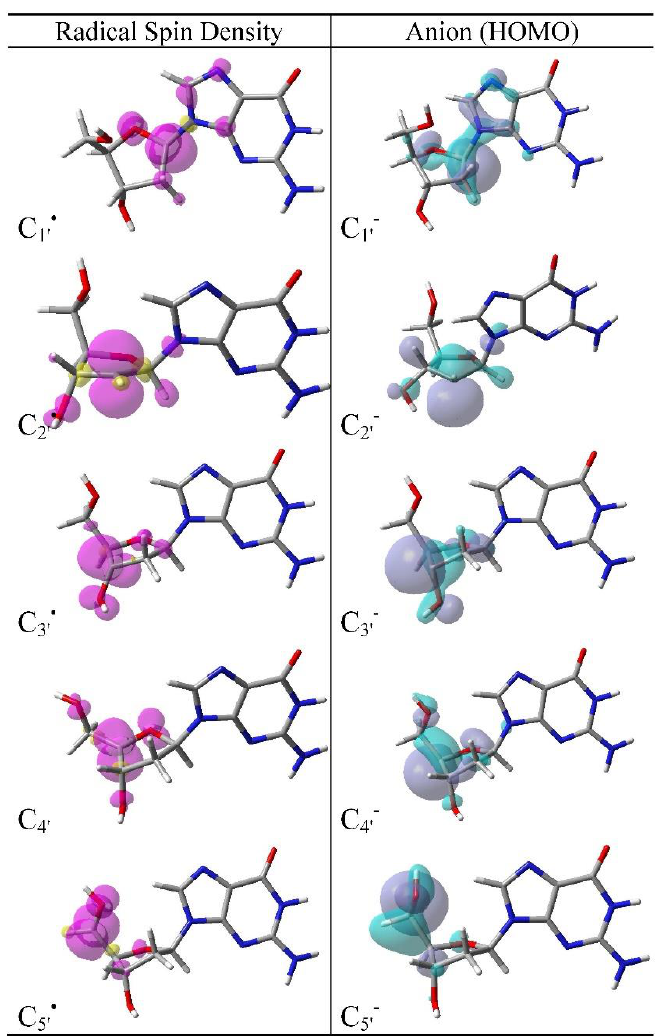
Figure 1. ωB97XD-PCM/6-31++G**-calculated Mulliken spin density distribution of sugar radicals (C1′ • , C2′ • , C3′ • , C4′ • , and C5′ • ) of 2′-dG (left column) and highest occupied molecular orbital (HOMO) of the one-electron reduced corresponding sugar radicals (anions) of 2′-dG (right col- umn). Spin density and HOMO are calculated at 0.004 and 0.04 electron/bohr 3 ,